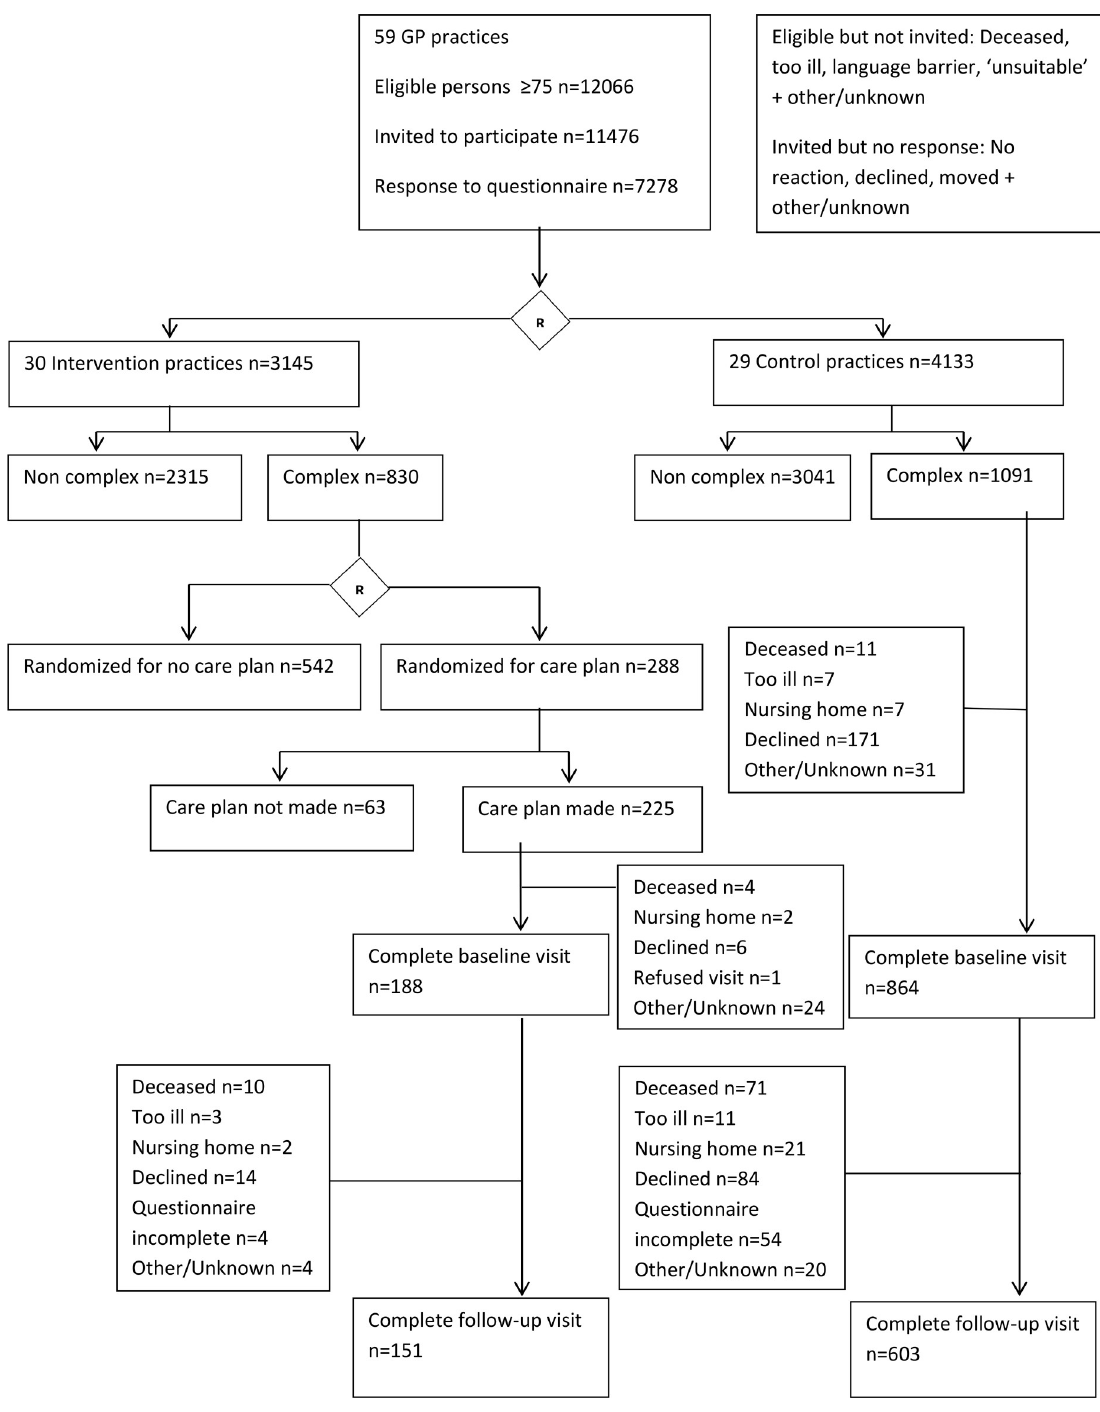
Fig 1. Flow chart showing the inclusion of study